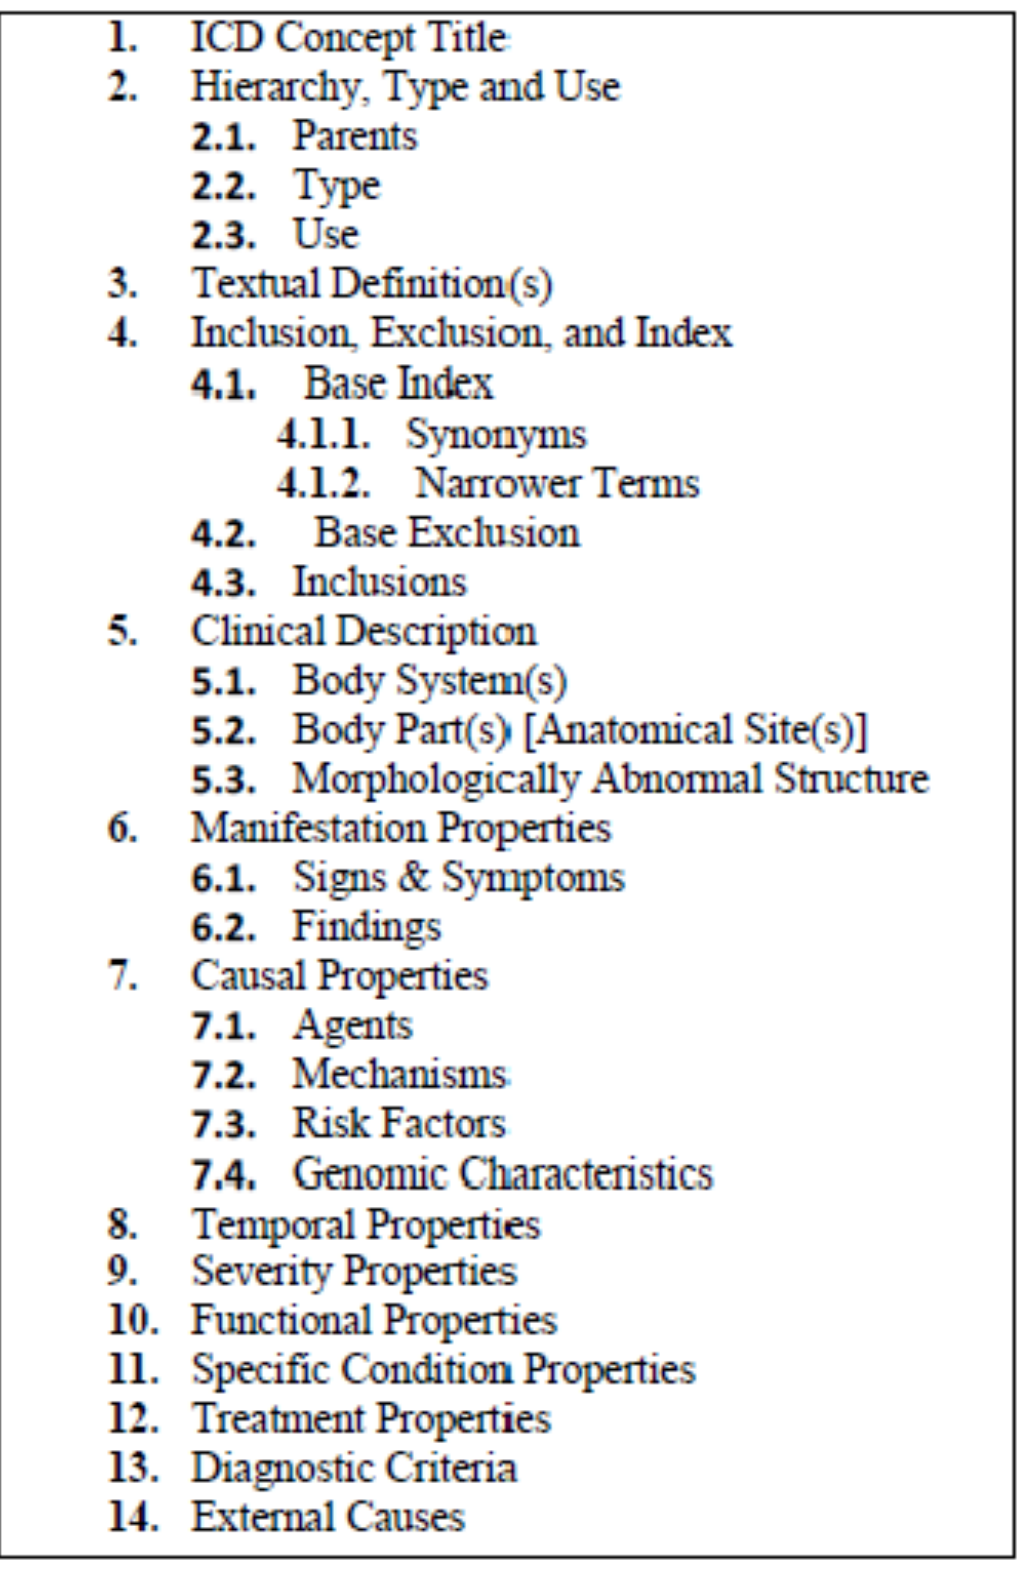
Figure 1. The categories of the ICD-11 Content